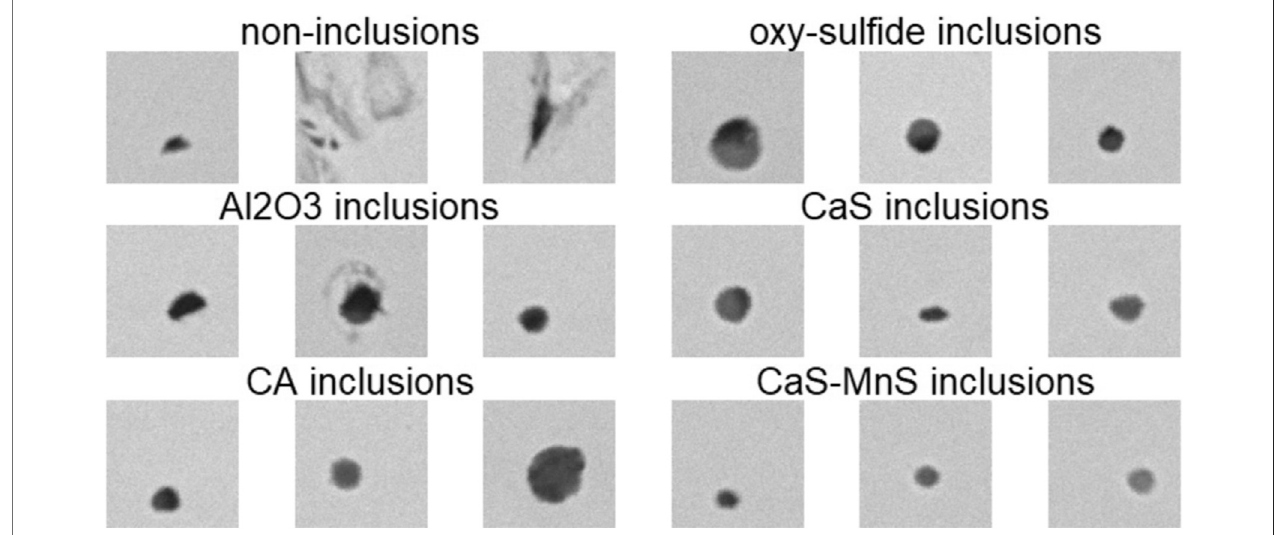
FIGURE 3 | Three BSE image examples for each of the selected inclusion classes.